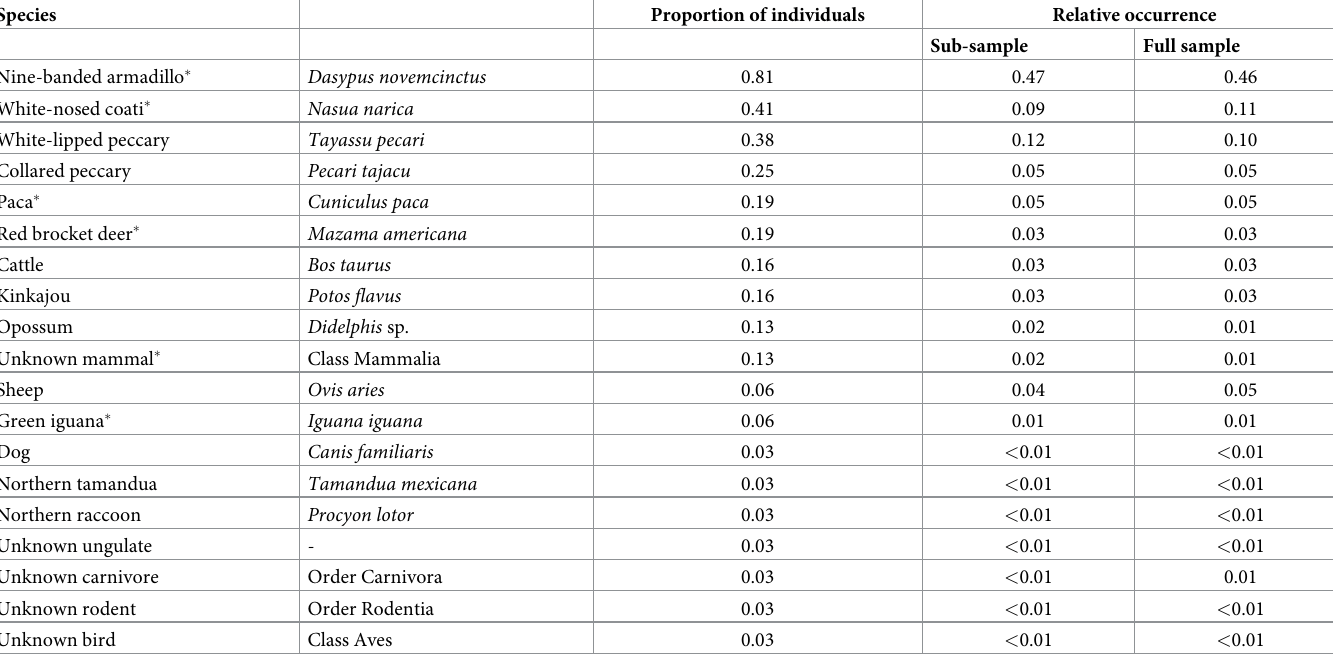
Table 1. Proportion of jaguars consuming each prey, and relative occurrence of prey in the pooled diet.